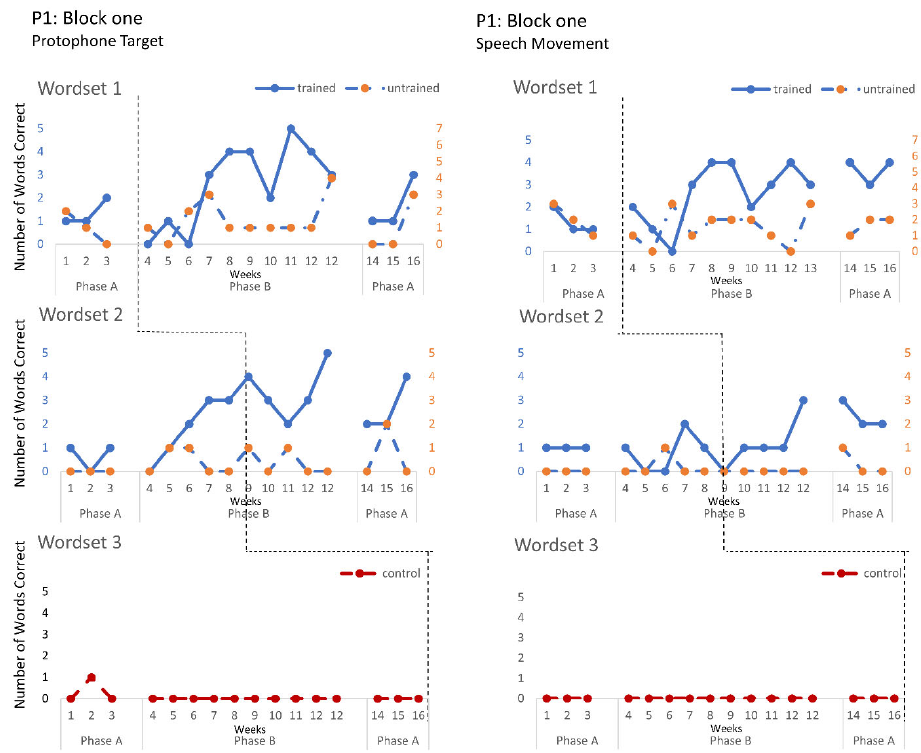
Figure 2. Accuracy of performance on the speech probes as scored for protophone target ( left ) and motor-speech movements ( right ) block one, participant 1.